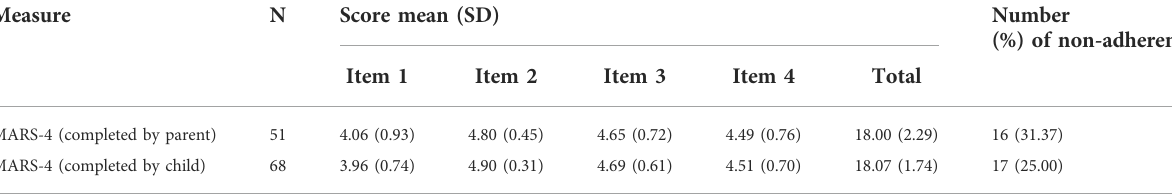
TABLE 3 The scores for the MARS questionnaires completed by participating parents and children.